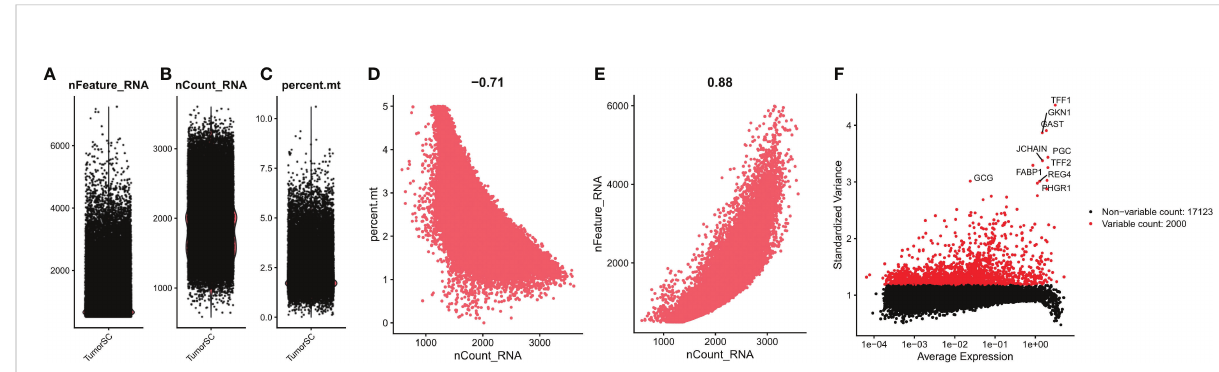
FIGURE 9 Quality control of single cell data. (A) represents the number of genes detected per cell; (B) represents the sum of the expression of all genes measured in each cell; (C) the proportion of mitochondrial genes detected; (D) Correlation between nFeature_RNA and percent.mt; (E) Correlation between nCount_RNA and nFeature; (F) Screening the top 2000 highly variable